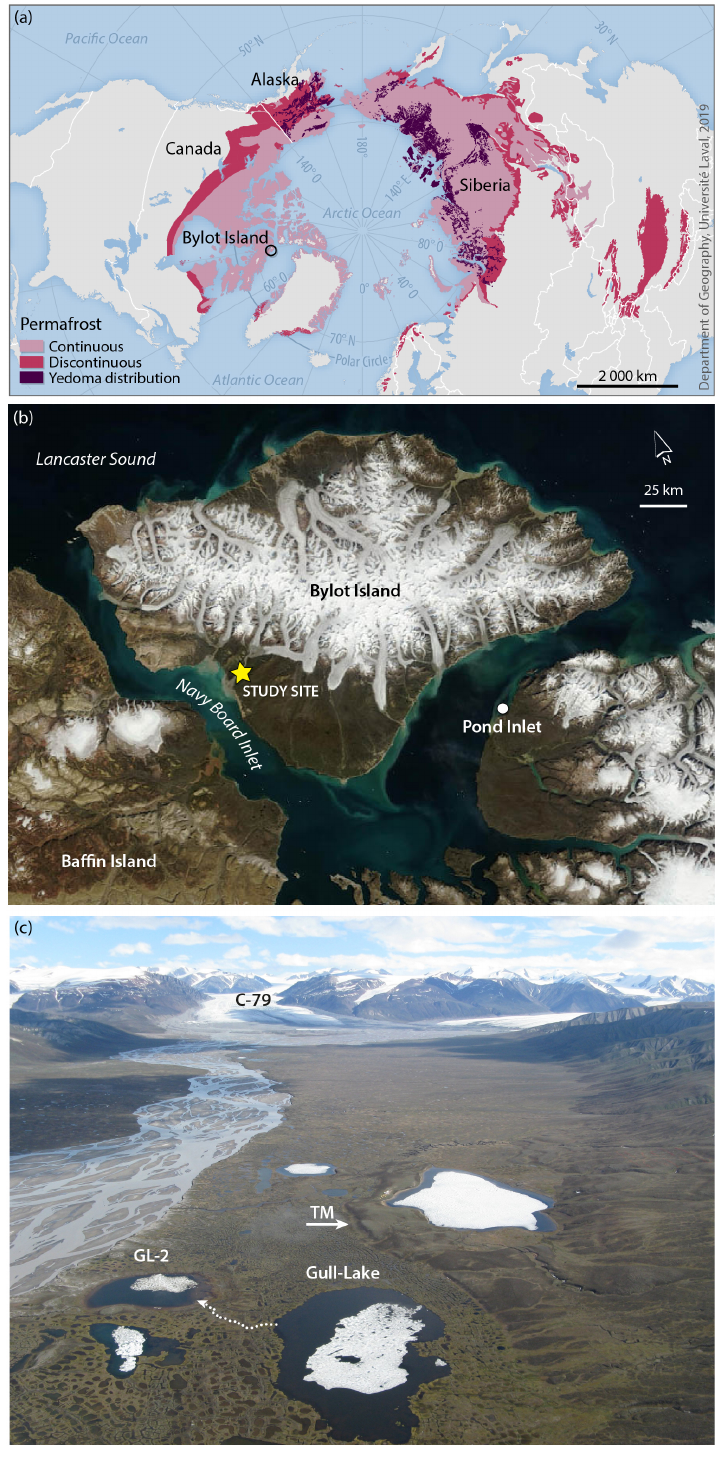
Figure 1. Study area location and context. (a) Location of Bylot Island (Nunavut), Canada, within the continuous permafrost zone (source: Brown et al., 1998). Pleistocene ice-rich permafrost distribution in nonglaciated regions of Siberia and Alaska (Yedoma) is also shown (source: Strauss et al., 2017). (b) Location of the study site on the southwestern lowlands of Bylot Island (satellite photo: Terra-MODIS, 22 July 2012). (c) Location of Gull Lake, in Qarlikturvik valley (glacier C-79 in the background). An early Holocene terminal moraine (TM) and a small outlet, draining towards “Gull Lake 2” (GL-2) and the proglacial river, are also